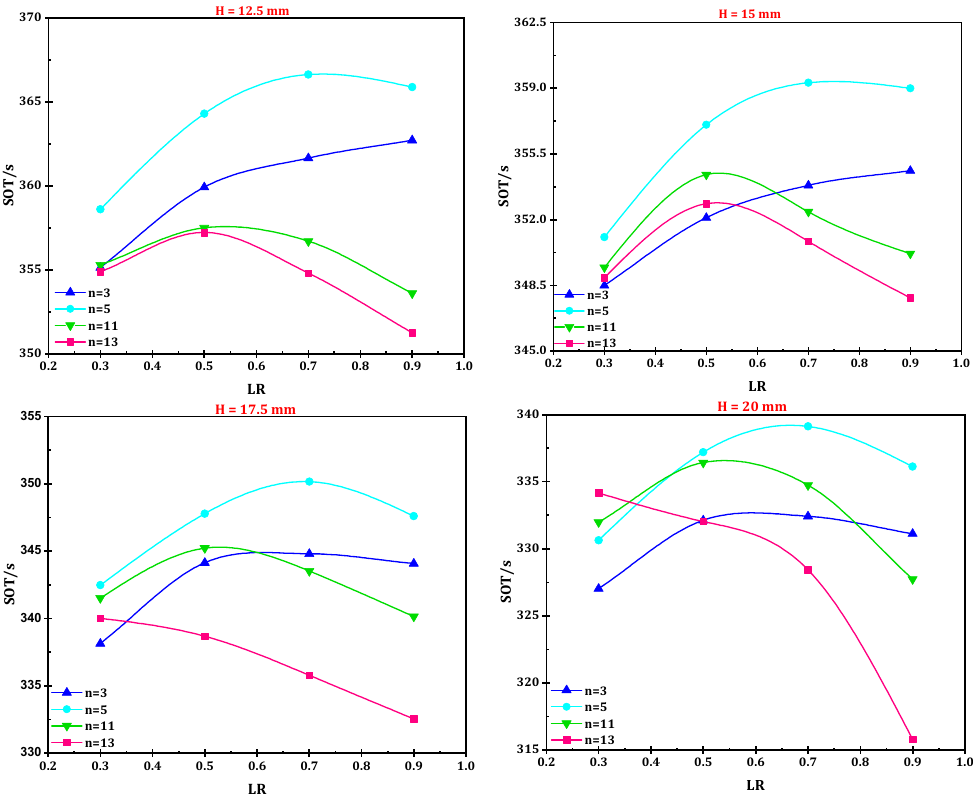
Figure 12. The variation in SOT with respect to LR at different heat sink height.